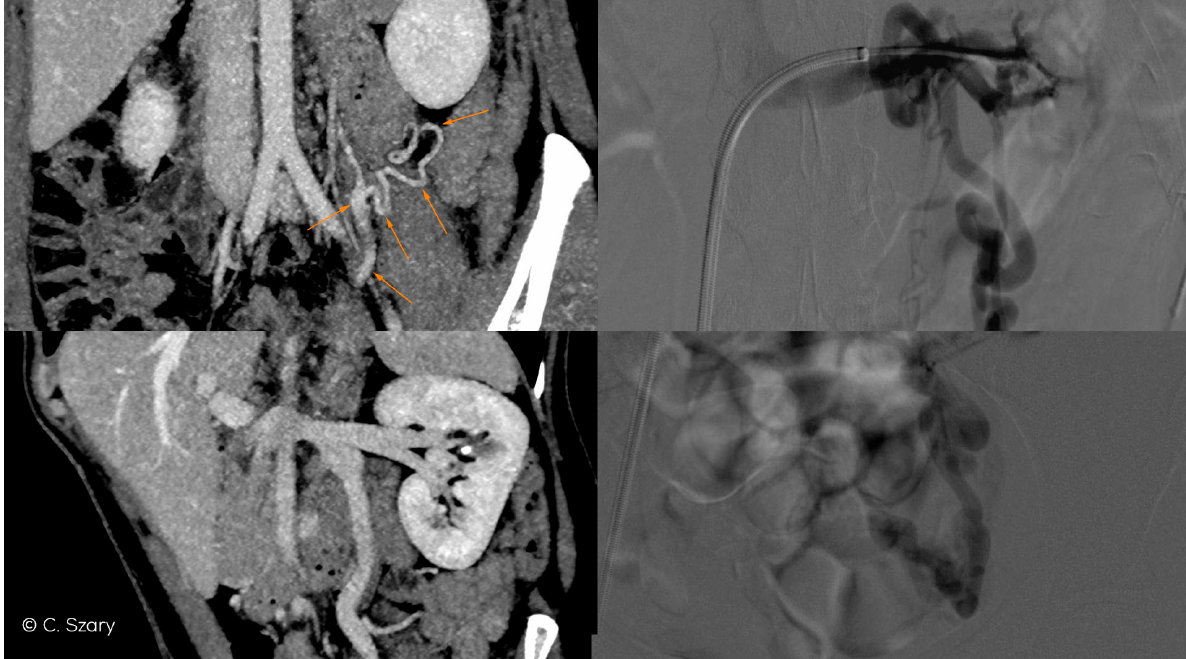
Figure 6. CTV and intra-interventional phlebographic images of nutcracker phenomenon (LRV compression by superior mesenteric artery, dilated venous collaterals from hilar veins of left kidney (orange arrows), insufficient LOV).